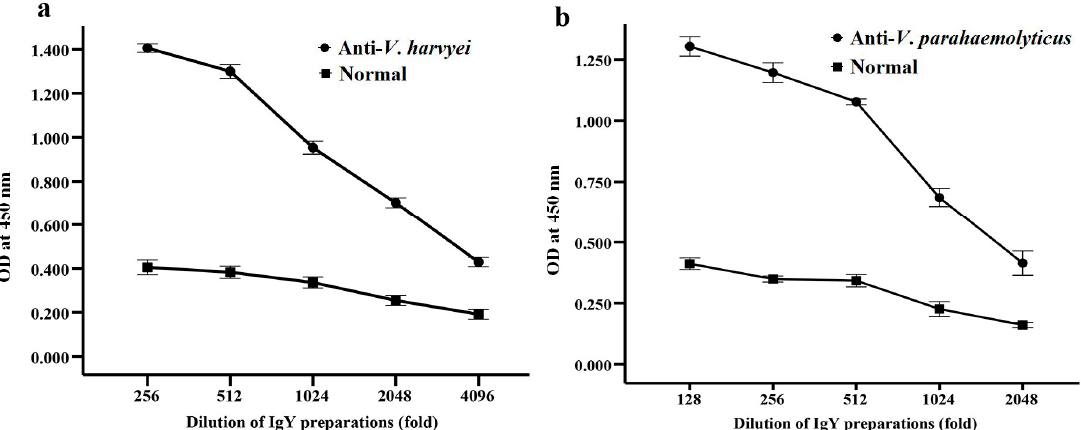
Figure 3. The titer of anti- V. harveyi and anti- V. parahaemolyticus IgY in the egg yolk powder by indirect ELISA. Data were presented as mean ± SD ( n = 3). ( a ) The titer of the egg powder against V. harveyi ; ( b ) The titer of the egg powder against V. parahaemolyticus.